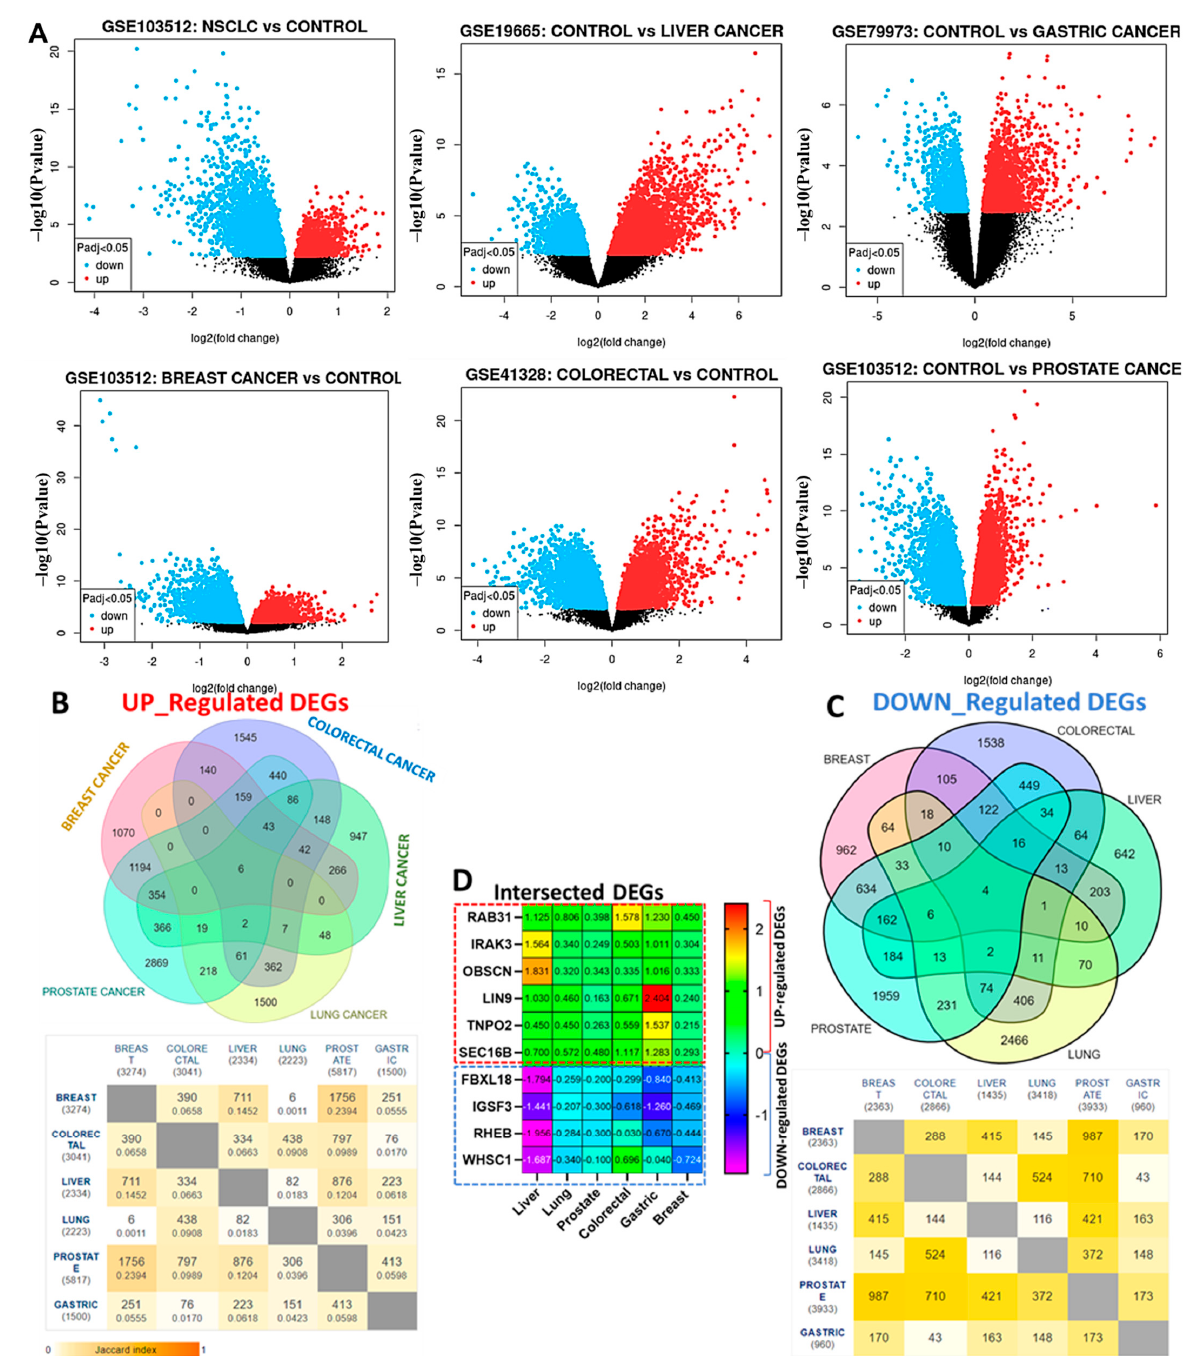
Figure 2. Identification of differentially expressed genes (DEG) between the cancer patients and healthy controls. ( A ) Volcano plot showing the distribution of DEGs between the cancer patients and healthy controls. The top DEGs are represented satisfying the criteria of logFC value and p < 0.05. The color indicates high expression (red) and low expression (blue). ( B ) The Venn diagrams of the overlapping up-regulated and ( C ) down-regulated DEGs in the six cancers. ( D ) Heat showing the logFC distribution of the 10 overlapping DEGs (6 up-regulated and 4 down-regulated genes) in all six GEO datasets.